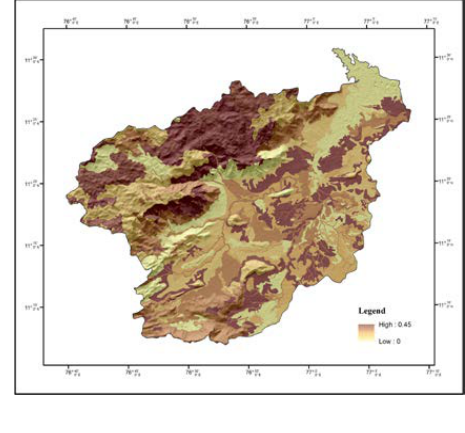
Figure 5. Soil Erodbility